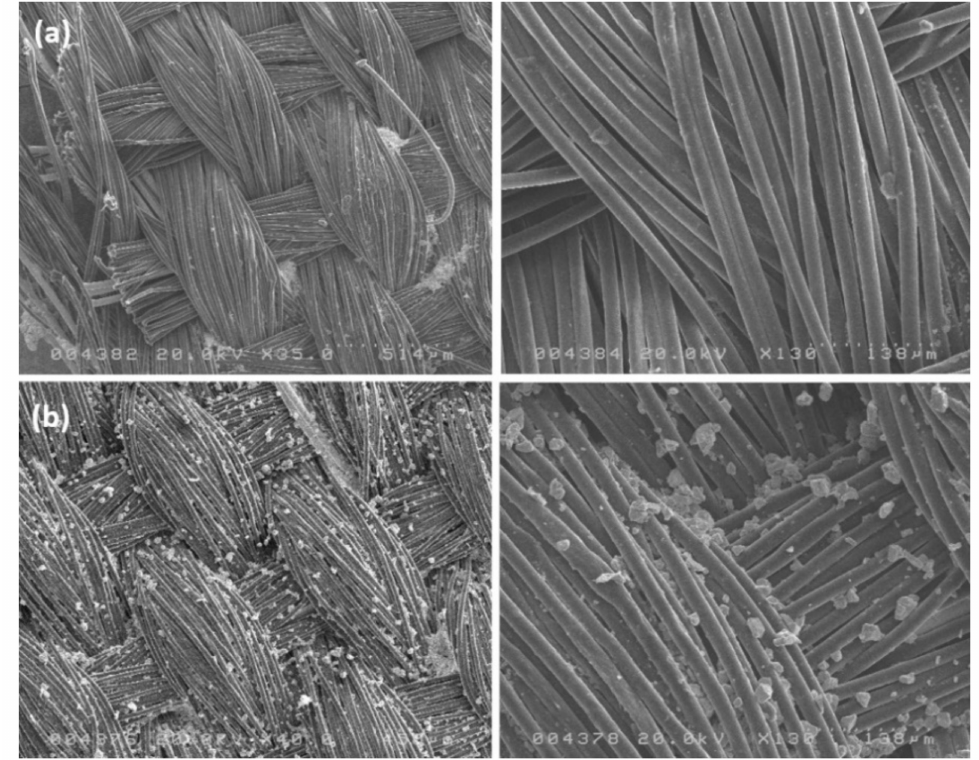
Figure 7. Enlarged electron microscope images of the fabrics. ( a ) Tungsten powder is not dispersed in the fabric, ( b ) Tungsten powder is dispersed.